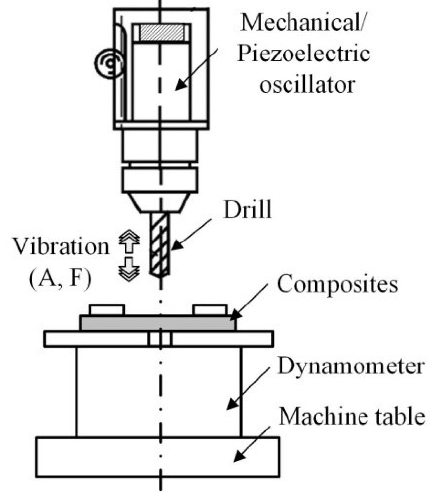
Figure 17. Illustration of vibration-assisted drilling [31].